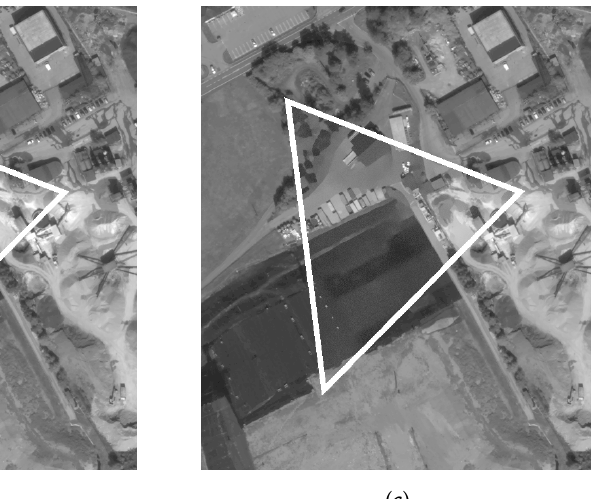
Figure 8. Panchromatic band and radiometric reconstructions—Detail 1. ( a ) WorldView-3 Panchromatic band; ( b ) HM reconstruction; ( c ) ED reconstruction.